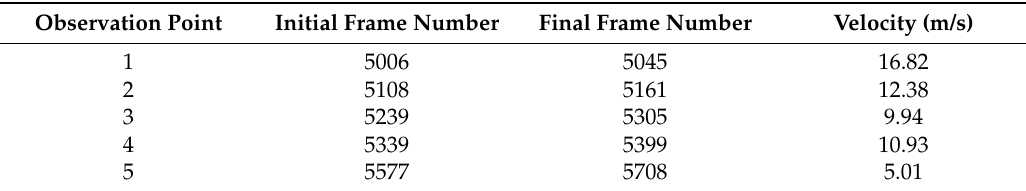
Figure 9. The images of particle migration in the late process of outburst (Observation point 4). ( a ) t = 0 (frame number 5339); ( b ) t = 2.93 ms; ( c ) t = 5.85 ms; ( d ) t = 8.78 ms; ( e ) t = 11.71 ms; ( f ) t = 14.63 ms (frame number 5399). Table 1. The velocity of the coal particles in late outburst